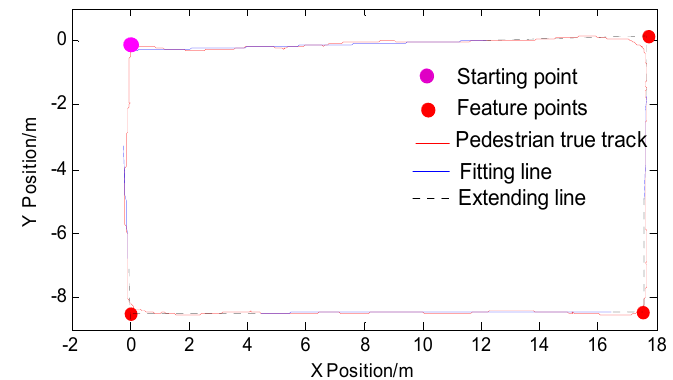
Figure 5. Feature points extraction based on location information.